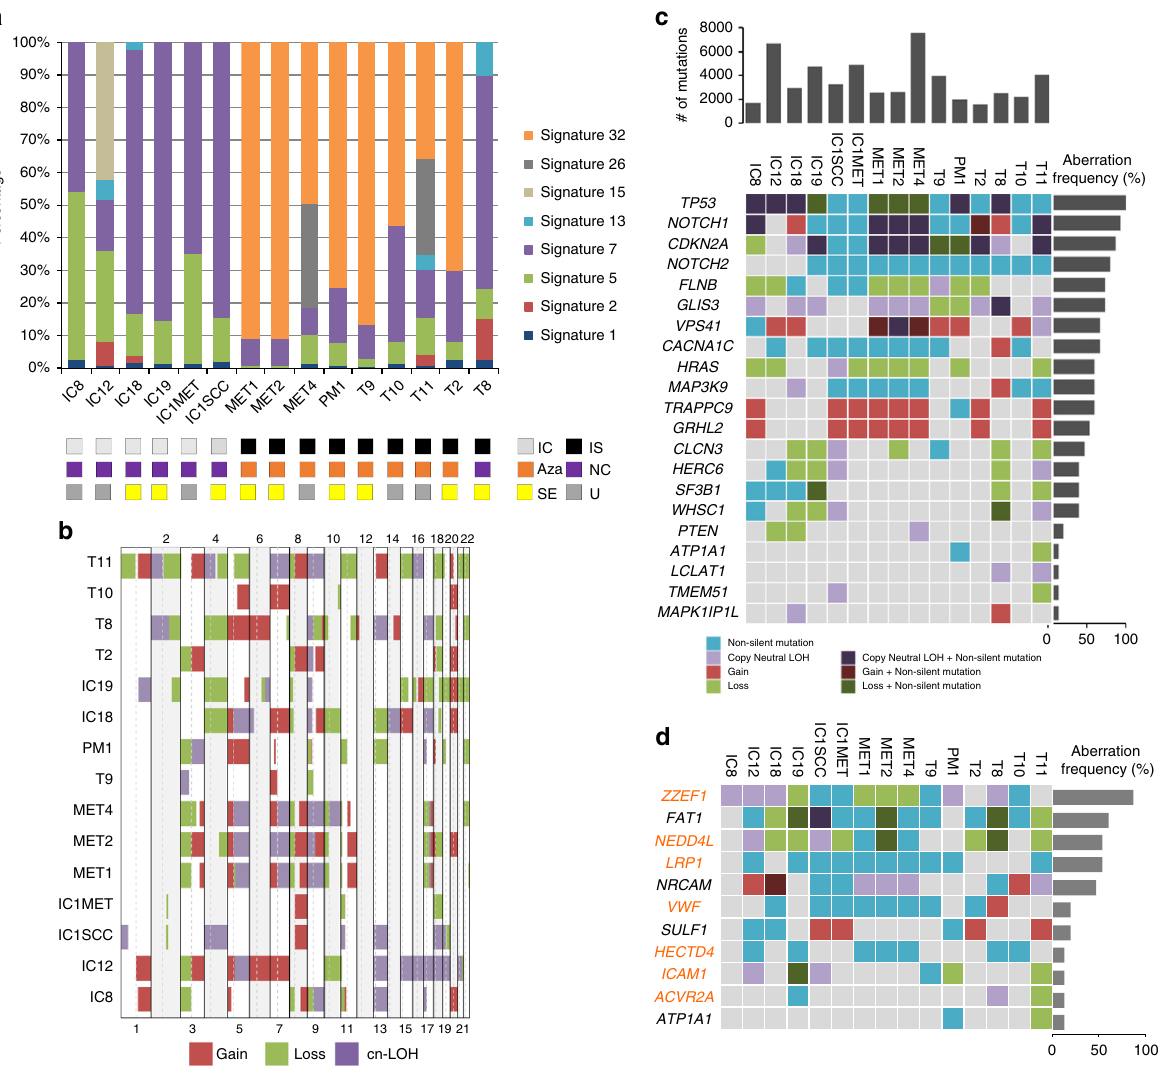
Fig. 8 Mutation signatures, somatic CNA/LOH and mutation pro fi les for identi fi ed SMGs in cSCC tumour samples in SCC cell lines. a Mutation signatures across all SCC cell lines. Again, signature 7 and 32 were the most dominant signatures. IC immunocompetent, IS immunosuppressed, Aza con fi rmed azathioprine exposure, NC no con fi rmed azathioprine exposure, SE sun exposed site, U unknown if sun exposed site b OncoPrint of copy gain, loss and CN- LOH segments. c Mutation OncoPrint for 22 SMGs detected in cSCC tumour samples across cell lines, ordered by aberration frequency. d Mutation OncoPrint for WD/MD/PD driver genes detected in cSCC tumour samples across cell lines, ordered by frequency. MD/PD-speci fi c genes found in cSCC samples are highlighted in